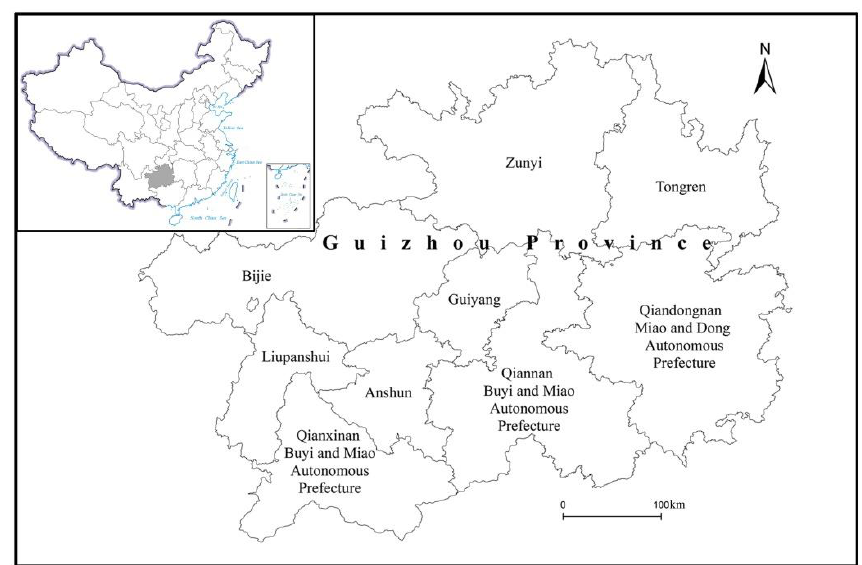
Figure 1. Map of Guizhou Province, China.